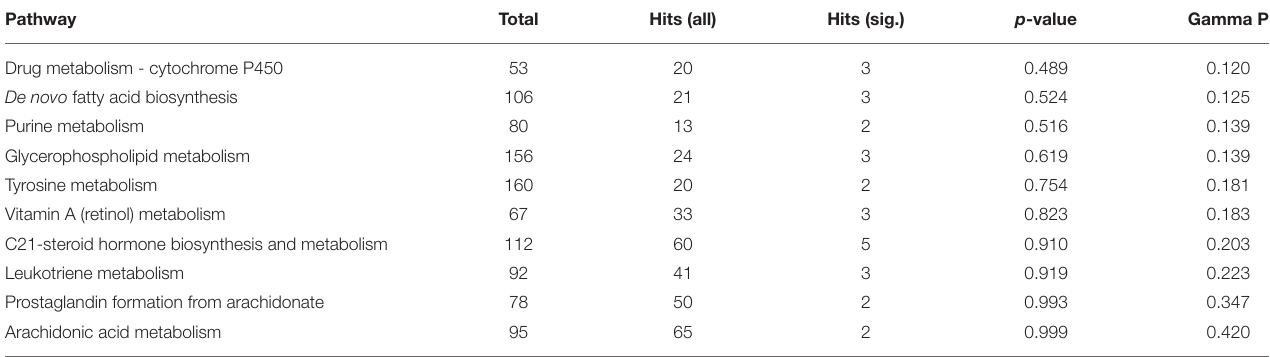
TABLE 1 | List of metabolic pathways identified in dog saliva after 30 days of placebo administration. Pathway Total Hits (all) Hits